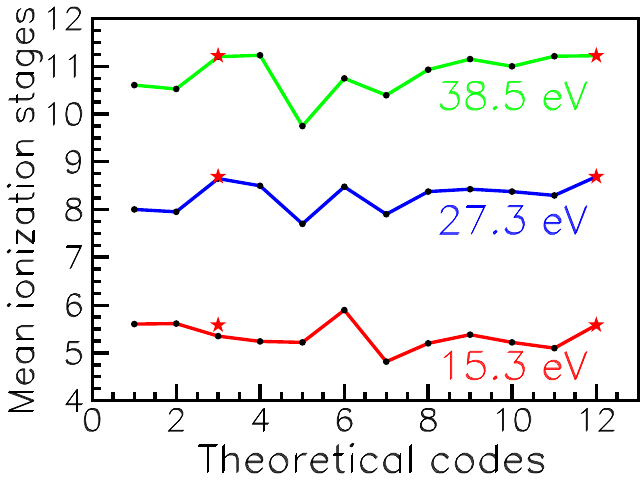
Figure 11. Iron mean ionization stages < q > obtained by various codes. Codes used are: